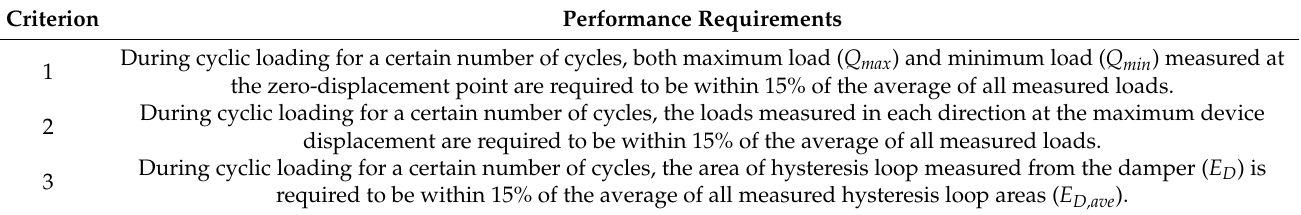
Table 5. Performance criteria for displacement-controlled seismic control systems.